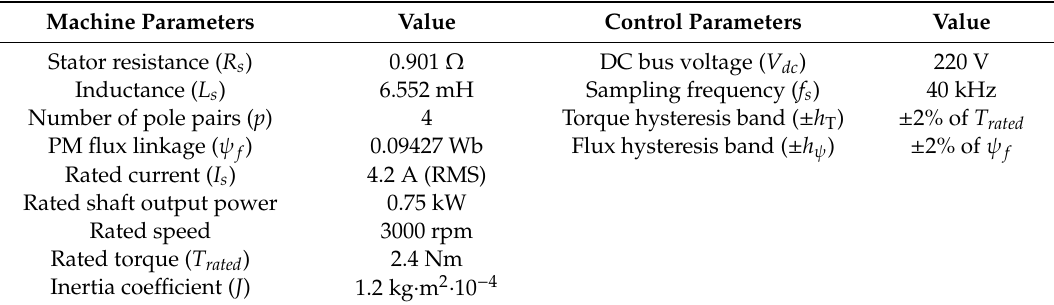
Table A1. PMSM and control